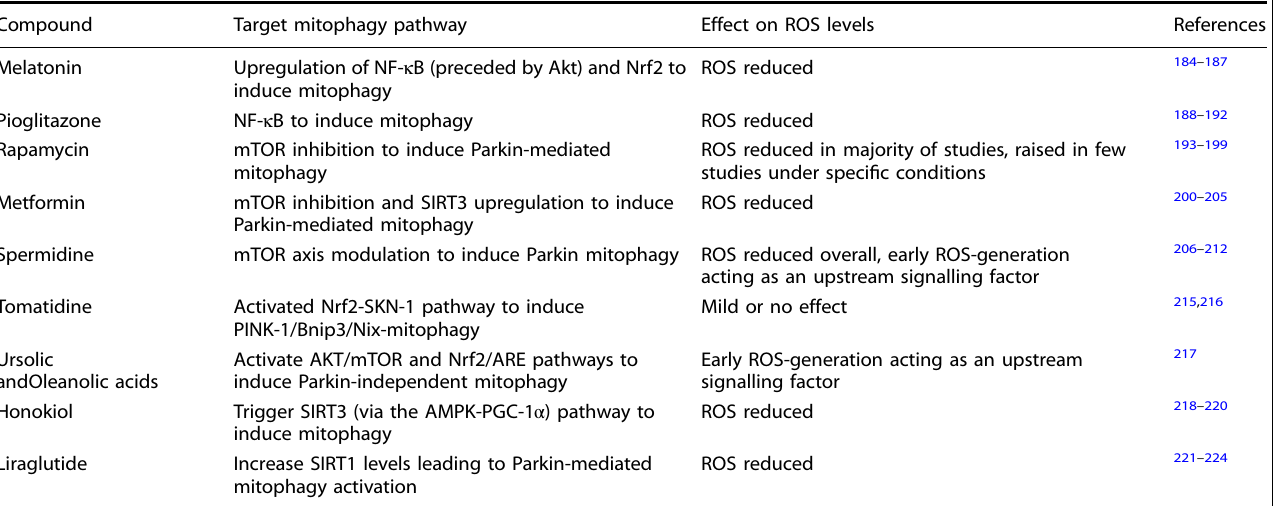
Table 1. Relevant compounds for consideration of ROS-mitophagy link. Compound